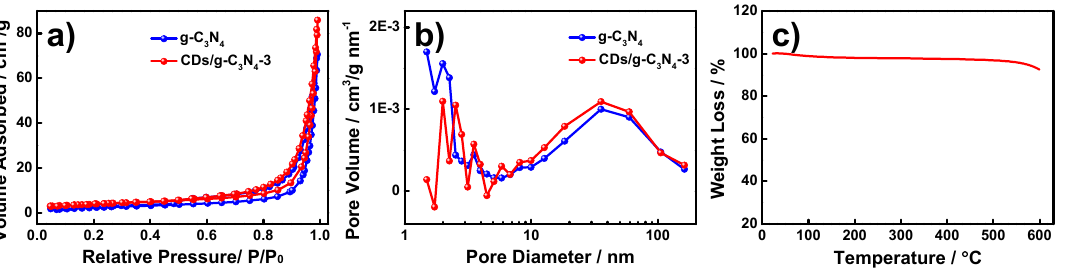
Figure 3. N 2 adsorption–desorption isotherms ( a ) and pore diameter distributions ( b ) of g-C 3 N 4 and CDs/g-C 3 N 4 , TG curve of CDs/g-C 3 N 4 ( c ).